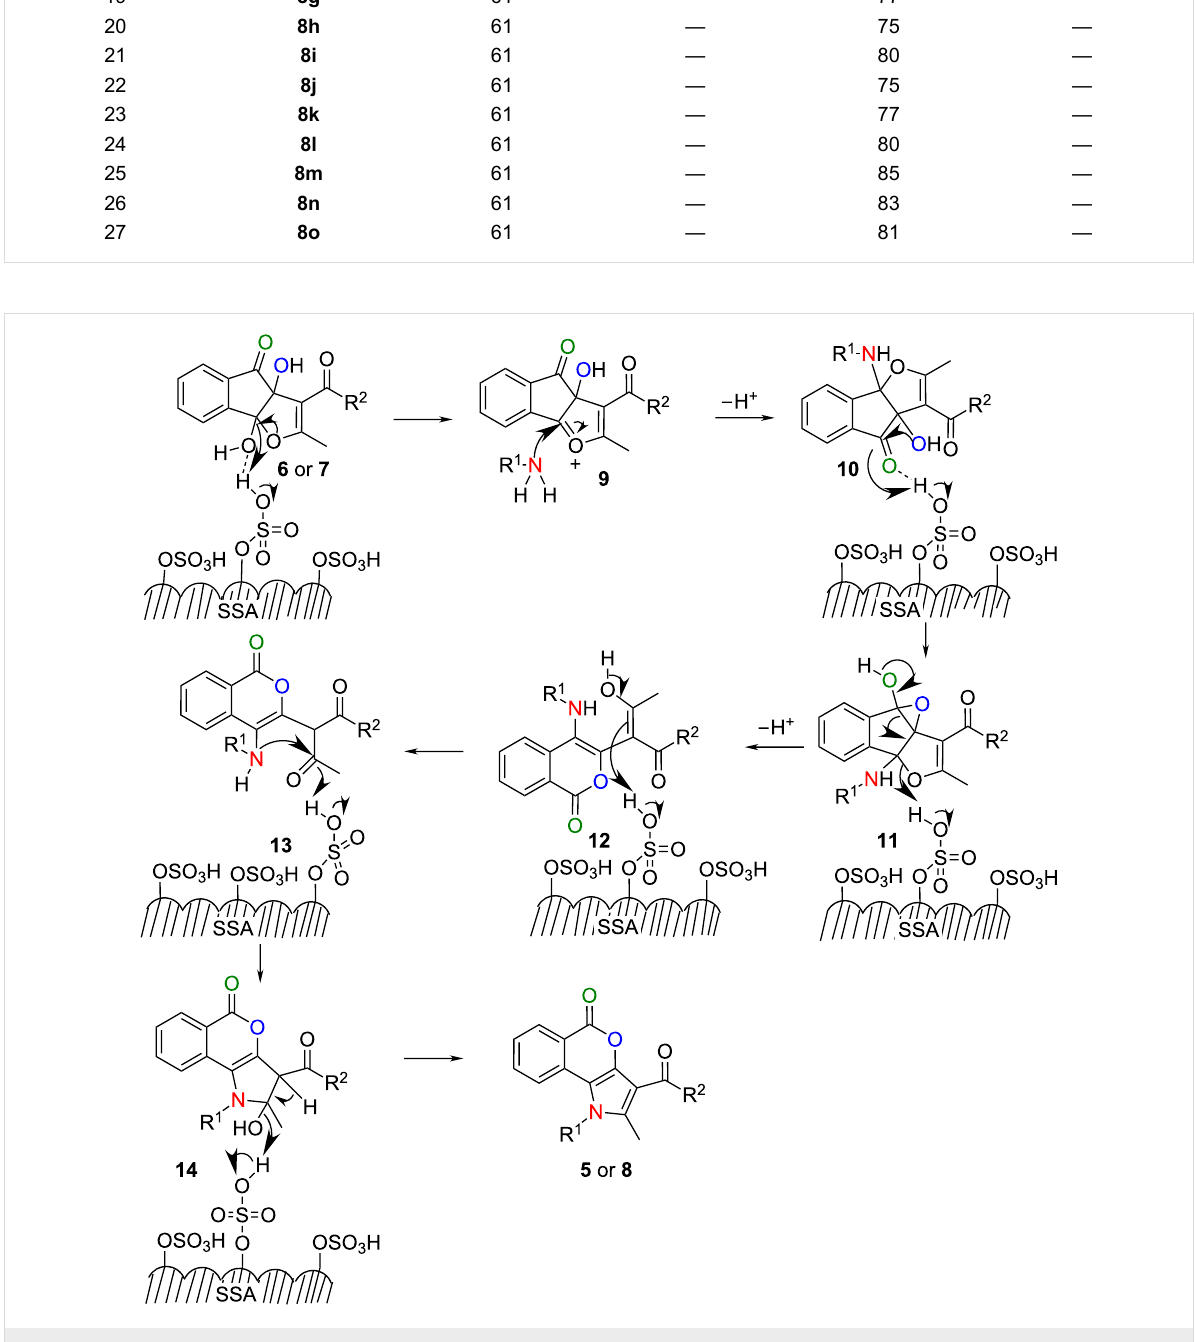
Scheme 3: Mechanism of formation of isocoumarins 5 or 8 on the surface of